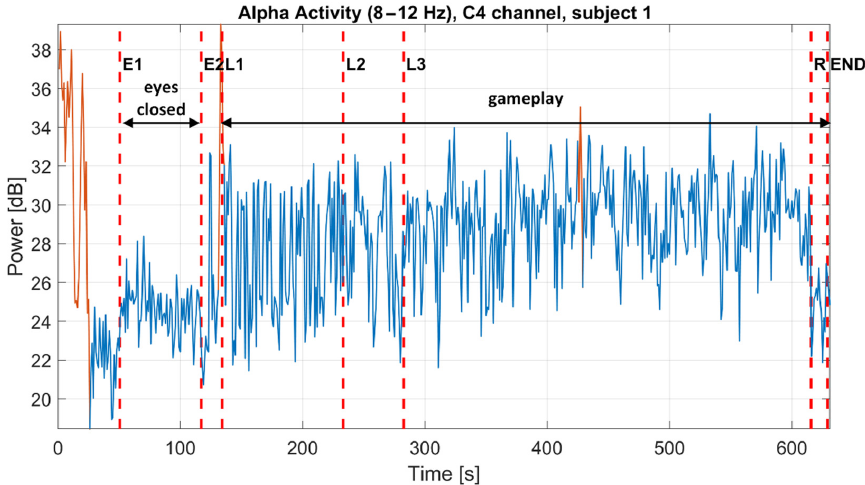
Figure 7. The average PSD of the alpha activity (8–12 Hz) of the subject 1. The beta/alpha ratio characterizes the relation between alpha and beta waves. The beta/alpha ratio increases when the brain is activated and decreases during brain inac- tivation. Therefore, this ratio is a significant parameter in evaluating brain response to some specific mental activity [68,69]. The development of the beta/alpha ratio during the experiment is shown in Figure 8. According to the graph, it is evident that the brain is more activated during the